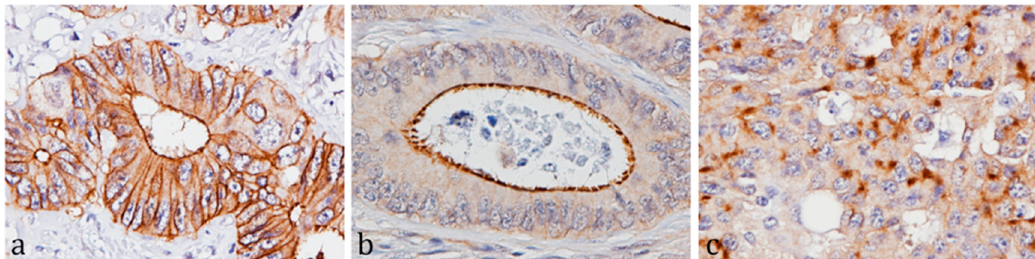
Figure 2. Immunostaining of ABCG2 in colorectal cancer (CRC) tissue demonstrating the three distinguishable ABCG2 immunoreactivity patterns in the cancer cells. ABCG2 was detected using the HiDef DetectionTM HRP Polymer system, visualized with 3,3’-diaminobenzidine-tetrahydrochloride (DAB + ), and counterstained with Mayer’s hematoxylin, 40 × magnification. ( a ) Basolateral membrane immunostaining, ( b ) apical membrane immunostaining, ( c ) cytoplasmic